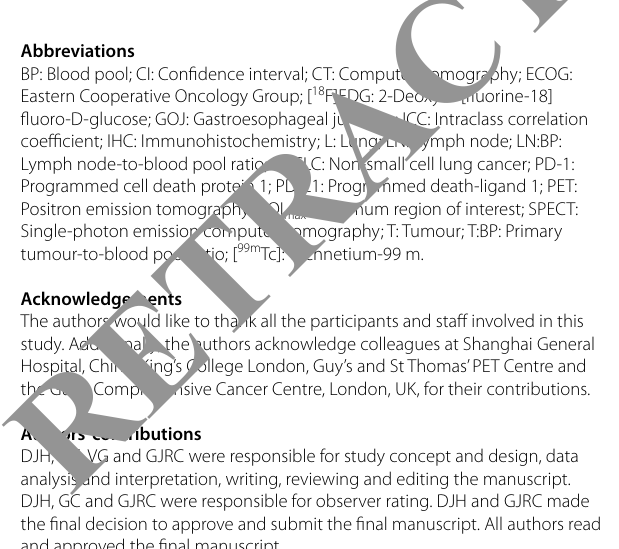
Fig. 3 Intraobserver Bland–Altman level of agreement plots for log 10 T:BP ( a , b ) and log 10 LN:BP ( c , d ) scores. Upper and lower 95% limits of agreement represented by dashed lines. Solid horizontal lines represent between-timepoints mean difference. a T:BP scores observer B, time 1 versus time 2 ( β 0.01, p 0.781); b T:BP scores observer C, time 1 versus time 2 ( β = = 2 ( β -0.08, p 0.183); d LN:BP scores observer C, time 1 versus time 2 ( β = =